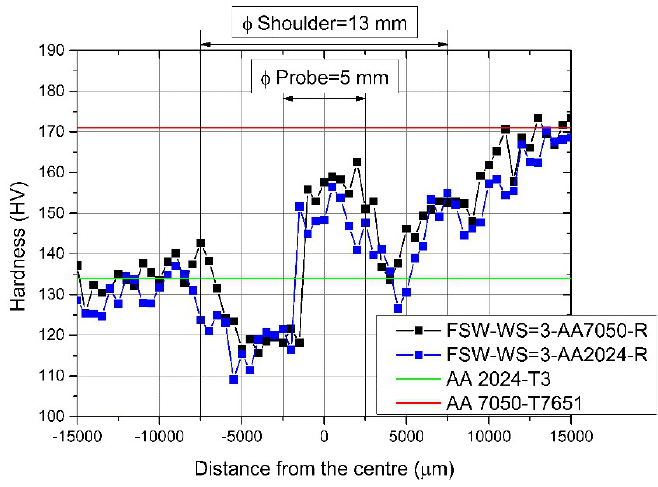
Figure 9. Microhardness test results for WS = 3 mm/s and the different positioning of the